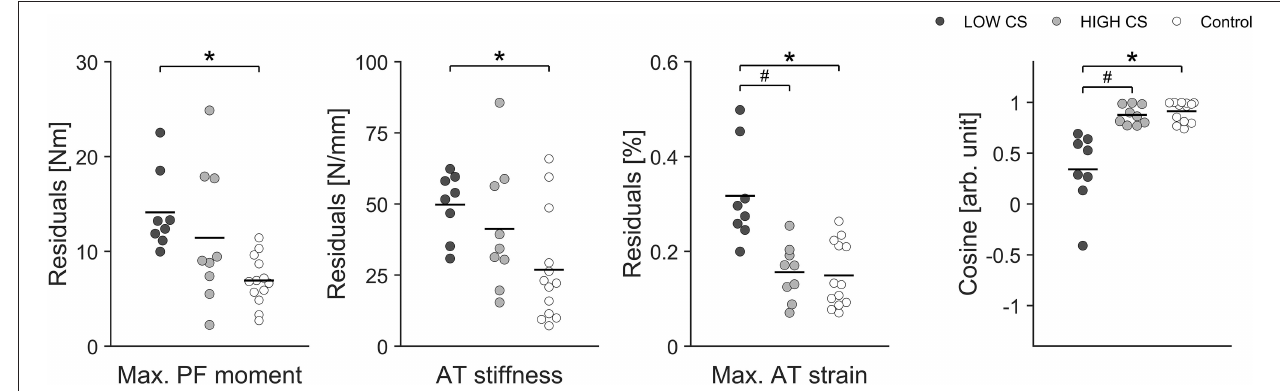
FIGURE 7 | Individual residuals and group means (dark line) in muscle strength (Max. PF moment), tendon stiffness (AT stiffness) and maximal tendon strain (Max. AT strain) as well as the cosine similarity (Cosine) of the relative changes of muscle strength and tendon stiffness between sessions over the 1 year observation in the take-off leg of the Low CS and High CS group of elite jumpers and in the control group. *Statistically significant difference between Low CS and control group ( P < 0.05). # Statistically significant difference between Low CS and High CS group ( P <